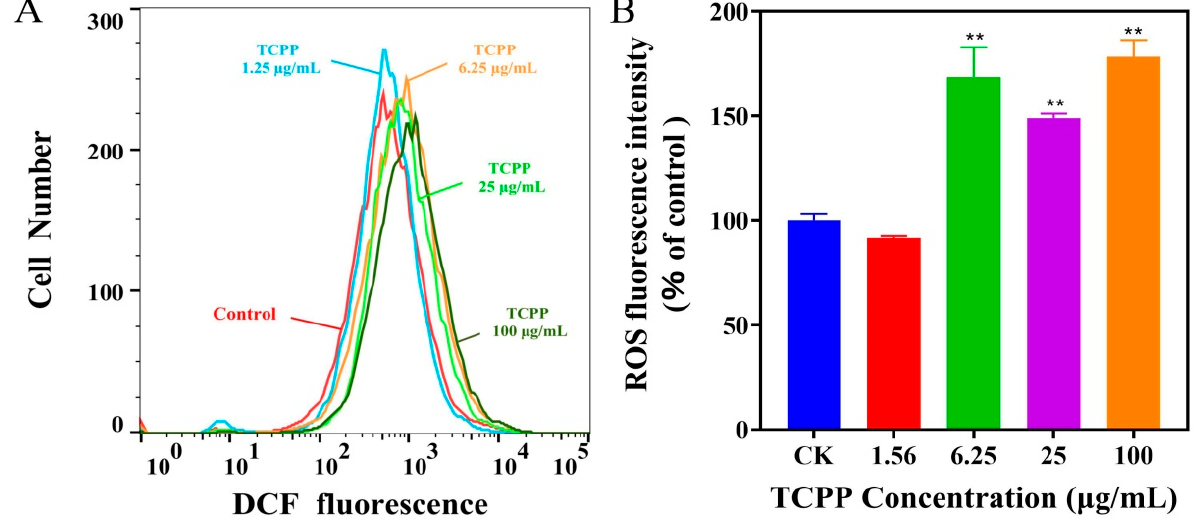
Figure 3. TCPP induced oxidative stress in HaCaT cells after 24 h exposure. ROS level was detected with DCFH-DA using a flow cytometer ( A ). The mean fluorescence intensity (MFI) was expressed as % of control ( B ). ** p < 0.01.